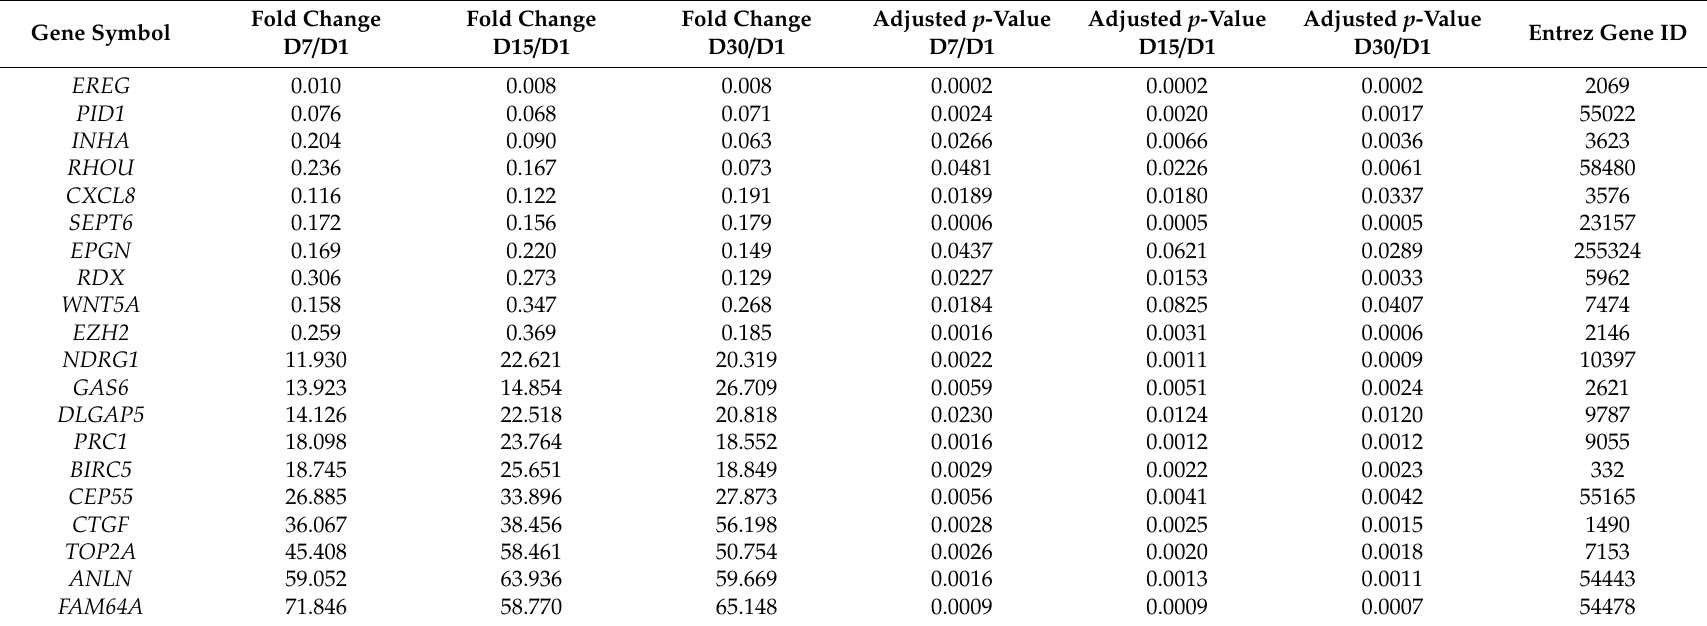
Table 2. Gene symbols, fold changes in expression, Entrez gene IDs, and adjusted p -values of the studied genes. Red: downregulated genes; green: upregulated